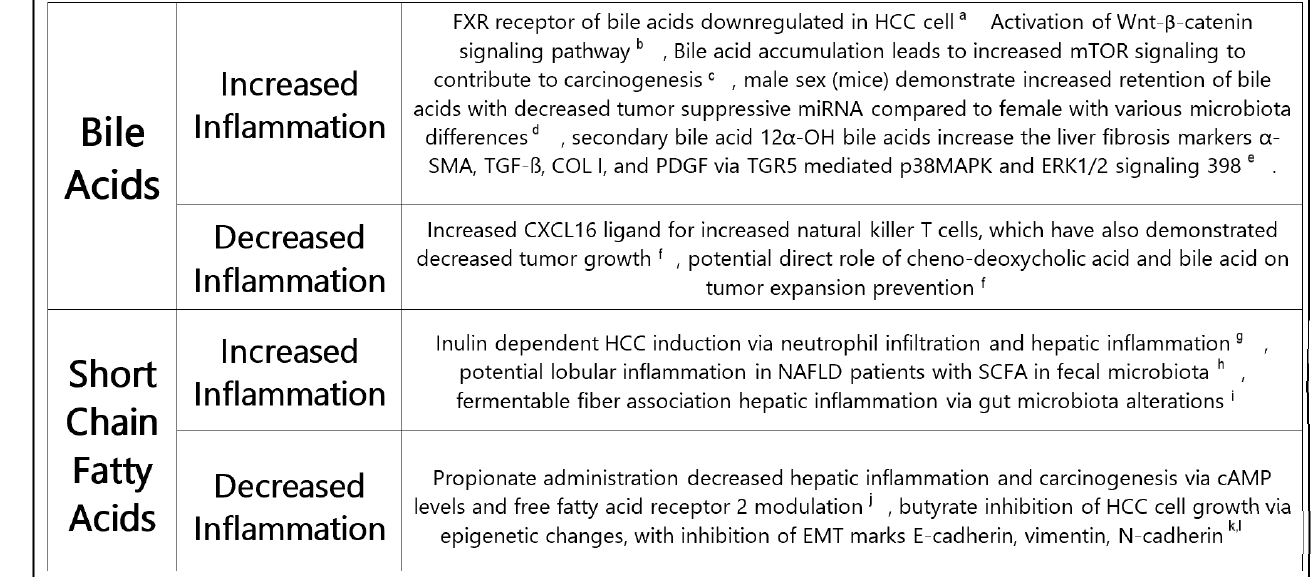
Figure 4. Effect of bile acids and short chain fatty acids on upregulation and downregulation of inflammatory processes which lead to HCC. a Su et al., 2012 [74], b Zhang et al., 2012 [75], c Yamada et al., 2018 [76], d Xie et al., 2017 [77], e Xie et al., 2021 [78], f Ma et al., 2018 [79], g Singh et al., 2018 [80], h Lee et al., 2020 [82], i Janssen et al., 2017 [83], j Gupta et al., 2019 [84], k Wang et al., 2013 [85], l Matsui-Yuasa et al., 2016 [86].